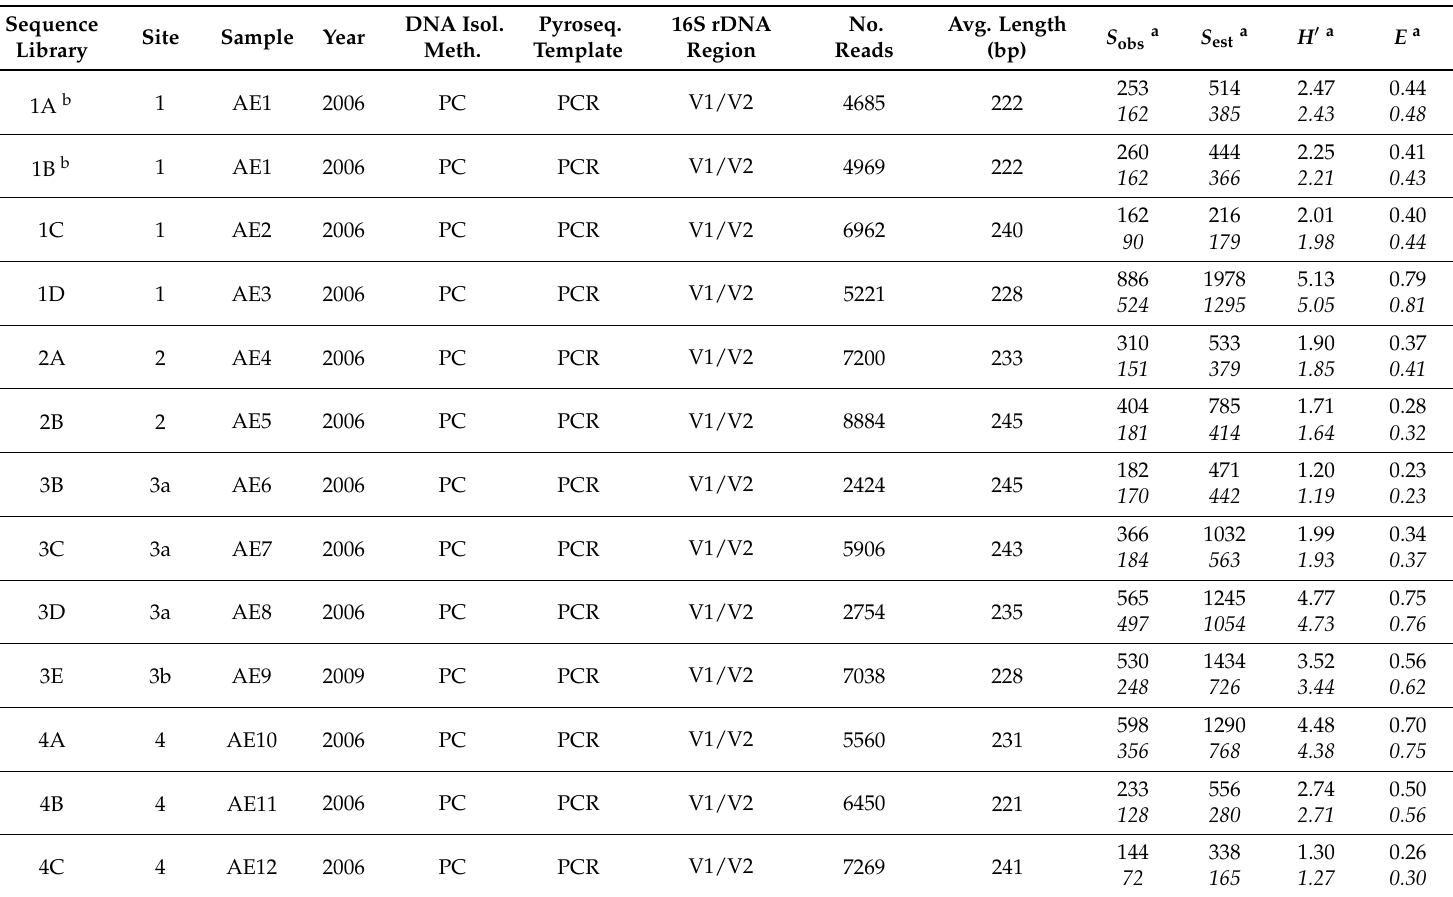
Table 1. Sample collection/processing information and alpha diversity analysis of A. elisabethae (AE) and seawater (W) samples. DNA isolation